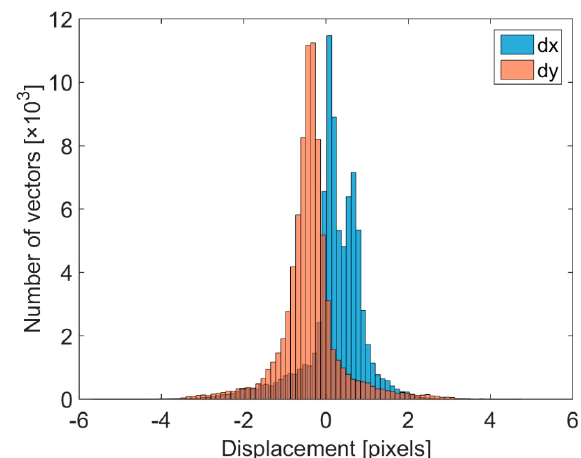
Figure 5. Histograms of the measured particle-image displacement at L/c = 1.0. (79,680 vectors in total, dx and dy are the particle-image displacements in the x and y directions).